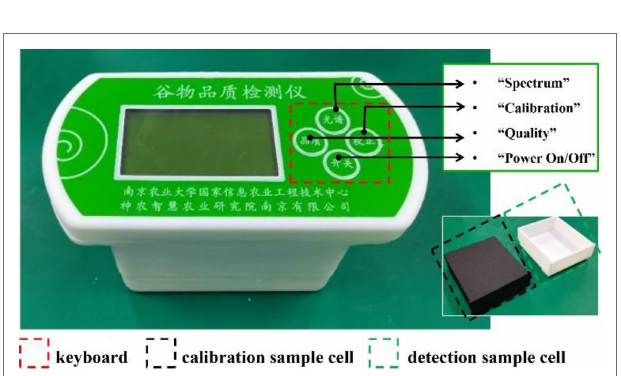
FIGURE 13 | The physical image of the NIR